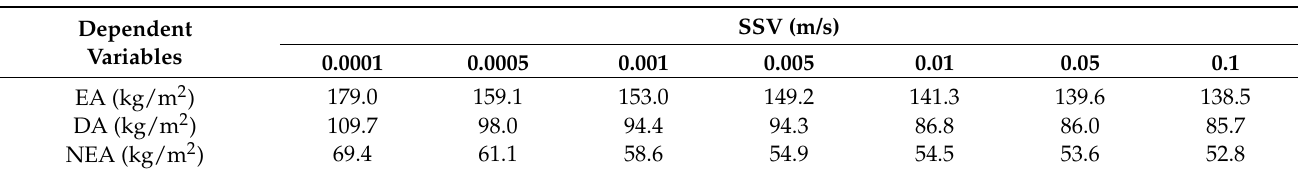
Figure 10. Terrain patterns of the ideal model of Qilihai Lagoon system under different SSVs, after 100 years, where the SSV is ( a ) 0.0001 m / s , ( b ) 0.001 m / s , ( c ) 0.01 m / s and ( d ) 0.1 m / s . Erosion amount (EA), deposition amount (DA), and net erosion amount (NEA) per unit area for different SSV, after 100 years, are shown in Table 3. Similar to the CDSS, the increase of SSV intensified the deposition, but the EA and the DA decreased, due to the aforementioned mutual restriction of erosion and deposition. When the SSV varied from 0.0001 m/s to 0.001 m/s, the NEA decreased by 10.8 kg/m 2 ; however, with a further in- crease of the SSV to 0.1 m/s, the NEA only declined by 5.8 kg/m 2 . This implies that low SSV has a greater influence on geomorphological evolution. Table 3. Erosion amount (EA), deposition amount (DA), and net erosion amount (NEA) per unit area for different SSVs, after 100 years.